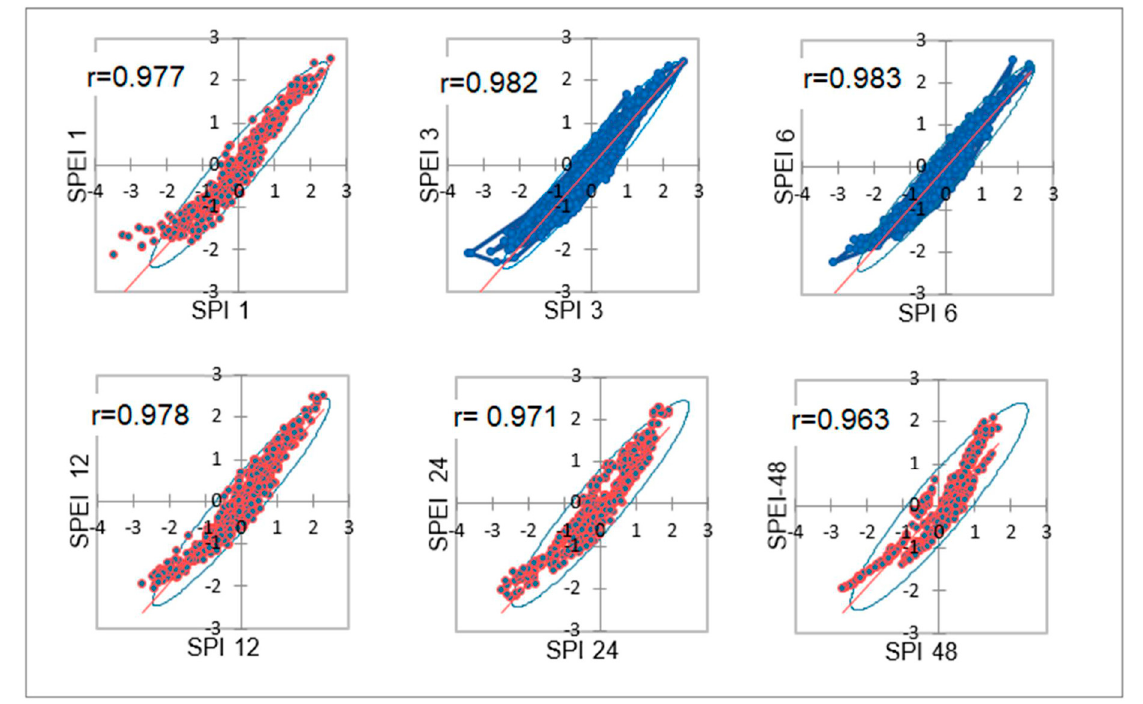
Figure 4. Correlation between SPI and SPEI in different time scales (Donji Miholjac meteorological